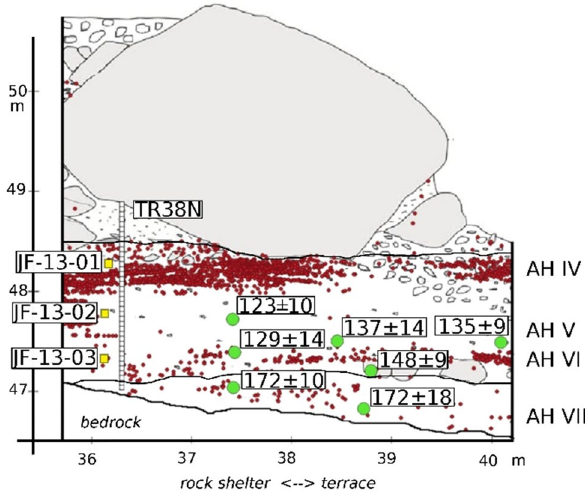
Figure 2. Northern profile of trench 38 at Jebel Faya showing the location of the lithic artifacts from AHs VII-IV (red dots), the location and results of the OSL samples presented here (green circles) as well as the samples for the sedimentological (white squares) and micromorphological study (yellow squares).